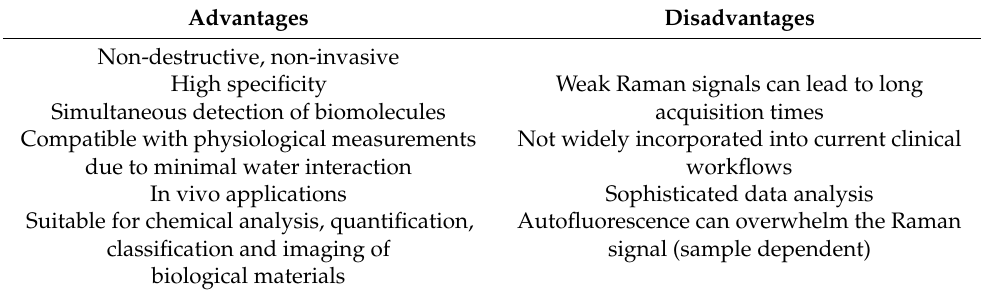
Table 2. Advantages and disadvantages of Raman spectroscopy for biomedical